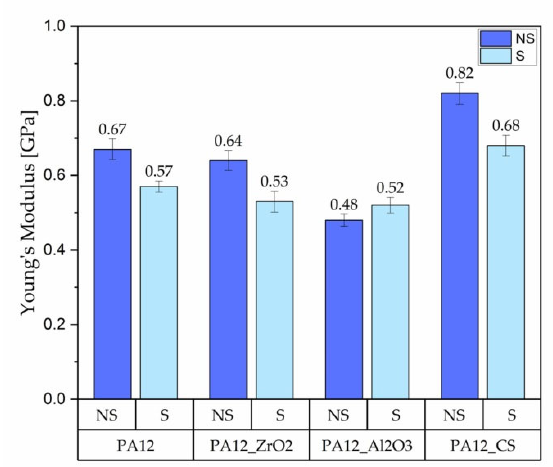
Figure 3. Young’s Modulus of the PA12, PA12_ZrO 2 , PA12_Al 2 O 3 and PA12_CS samples in their non ‐ sterilised/initial state and after sterilisation.